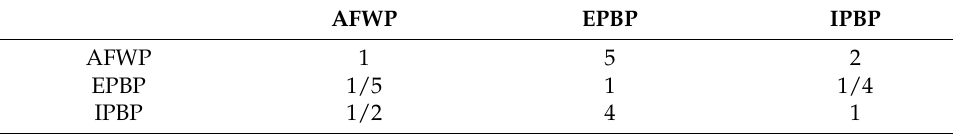
Table 4. Pairwise comparison matrix of decision criteria with respect to the goal. AFWP EPBP IPBP AFWP